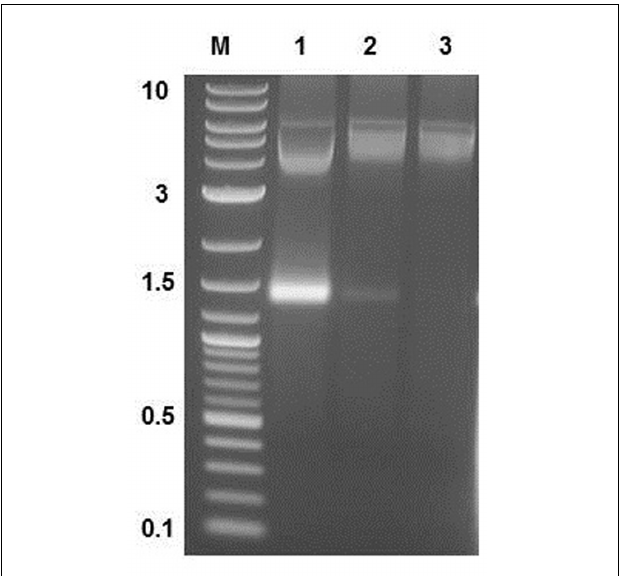
FIGURE 3 | Result of agarose gel electrophoresis (1%) detection of MS2 phage-like particles (MS2 PLP) in three layers removed after ultracentrifugation from the tube. 1, top layer; 2, middle layer; 3, lower layer. M, marker 2-log DNA ladder (New England Biolabs, UK), the marker values are in kb. The top layer contained the highest amount of MS2 PLP (the band on the gel around 1.5 kb).